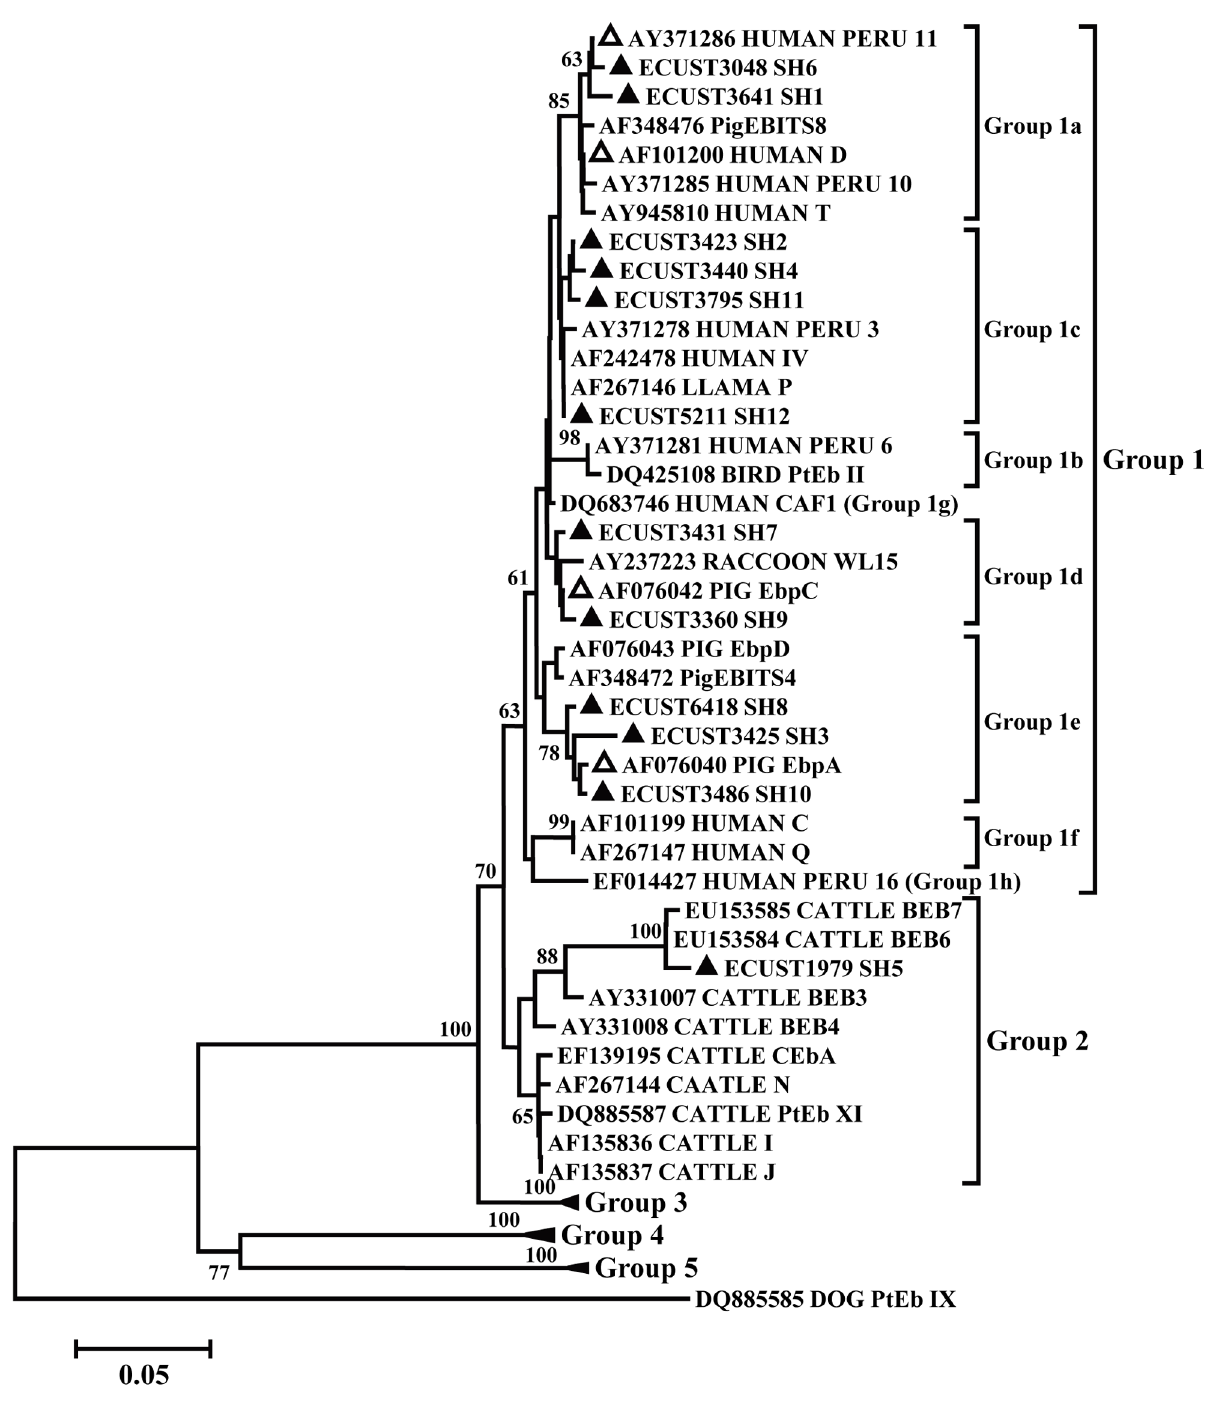
Figure 3. Phylogenetic relationship of Enterocytozoonbieneusi genotypes. The relationship of genotypes identified in this study and some other genotypes in GenBank was inferred by a neighbor-joining analysis of ITS sequences, based on the p-distance model. Bootstrap values . 50% are shown. Novel and known genotypes identified in this study are indicated by black and white triangles, respectively.